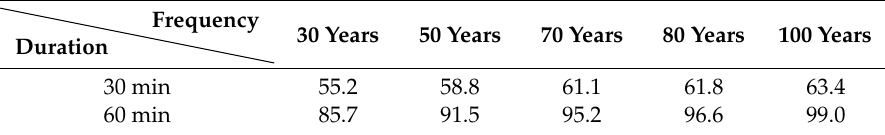
Table 1. Synthetic Rainfall (mm) according to Duration and Frequency obtained from a Seoul weather station (108) [50].